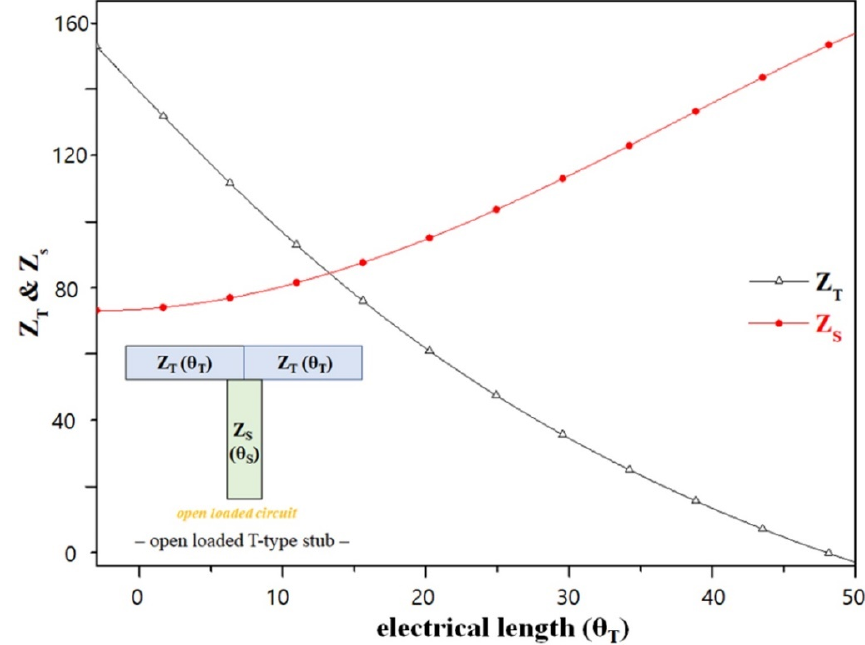
Figure 3. Change in electrical length according to the impedance of the